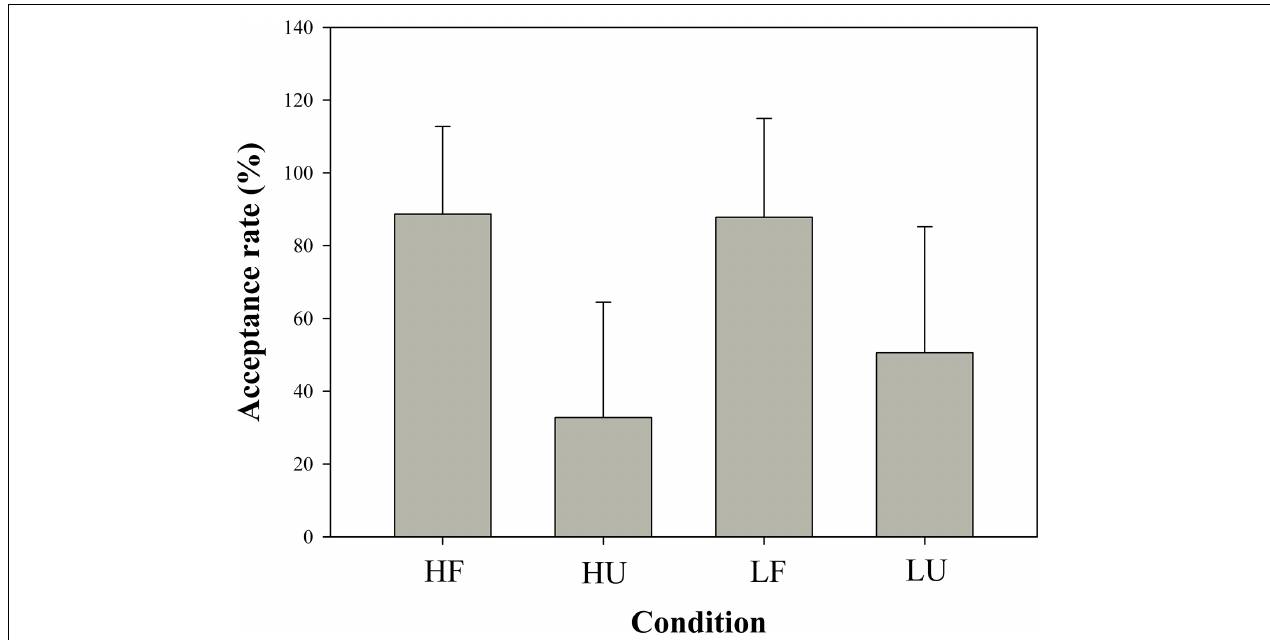
FIGURE 2 | Acceptance rates for four conditions: “high objective wealth-fair” (HF), “high objective wealth-unfair” (HU), “low objective wealth-fair” (LF), “low objective wealth-unfair”